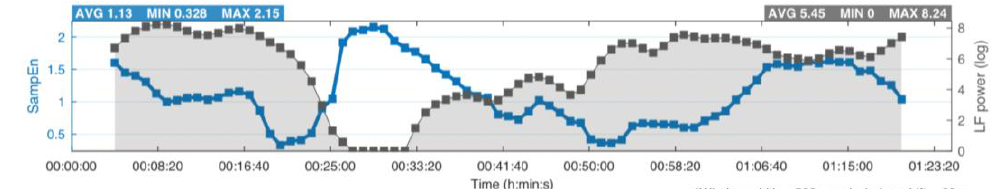
Figure 1. LF power (log) of HRV presented with a black dotted line. Medium- to high-intensity exercise decreases the LF power of HRV to imperceptible values [5], exhibited at around 26 min. The figure presentation is only demonstrative, constructed using Kubios HRV software (Kubios Oy, Kuopio, Finland, https://www.kubios.com, accessed on 23 February 2023).